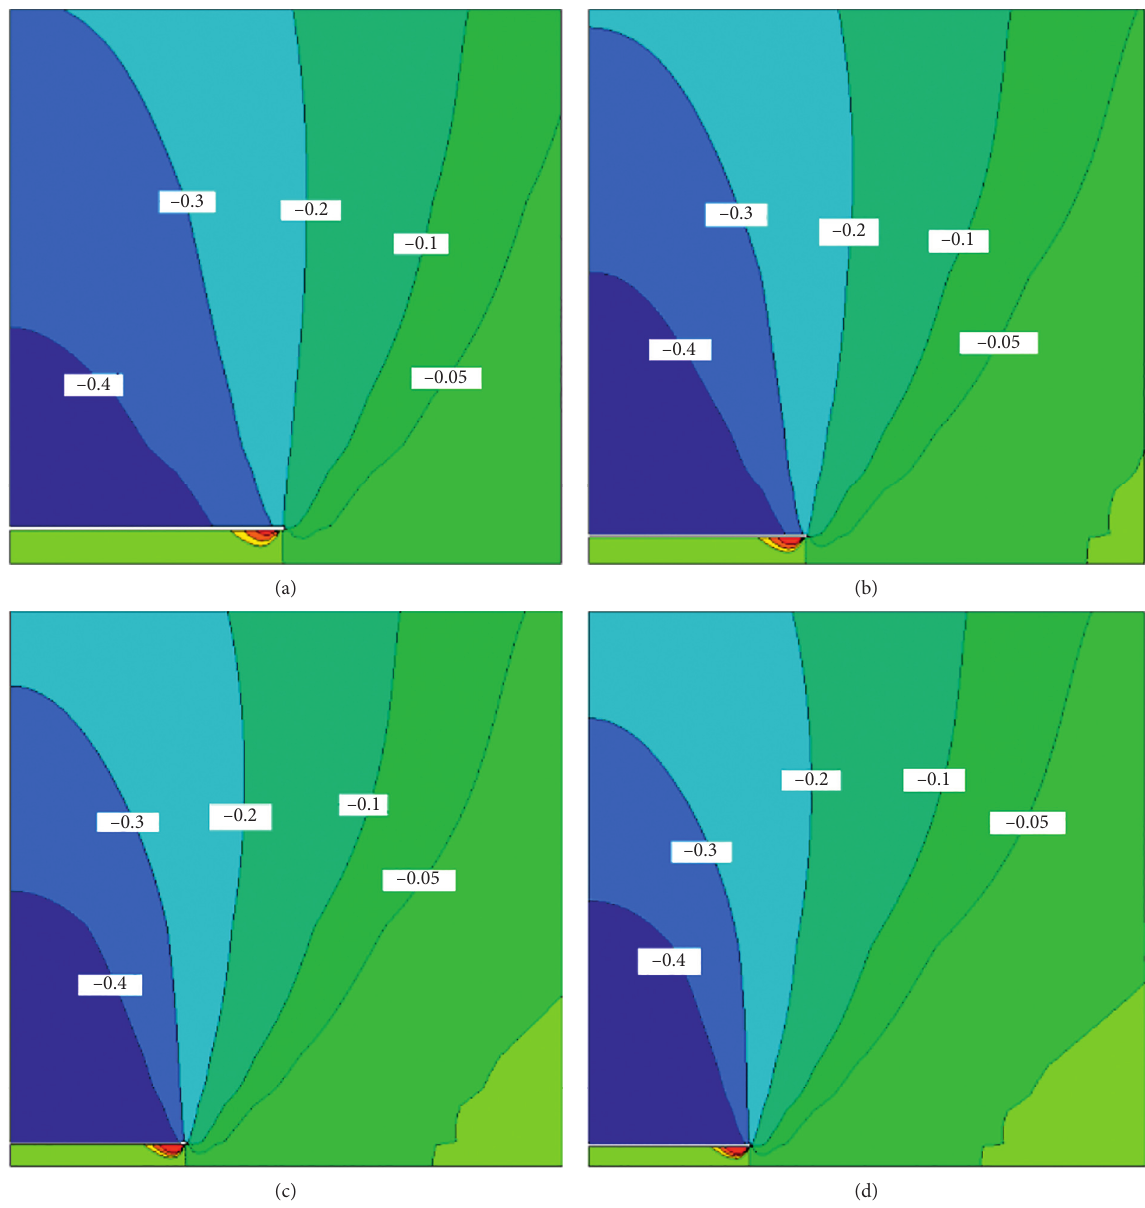
Figure 10: Contour map of vertical displacement of overburden in solid backfill mining at different mining depths: (a) H � 350m; (b) H � 450m; (c) H � 550 m; (d) H �